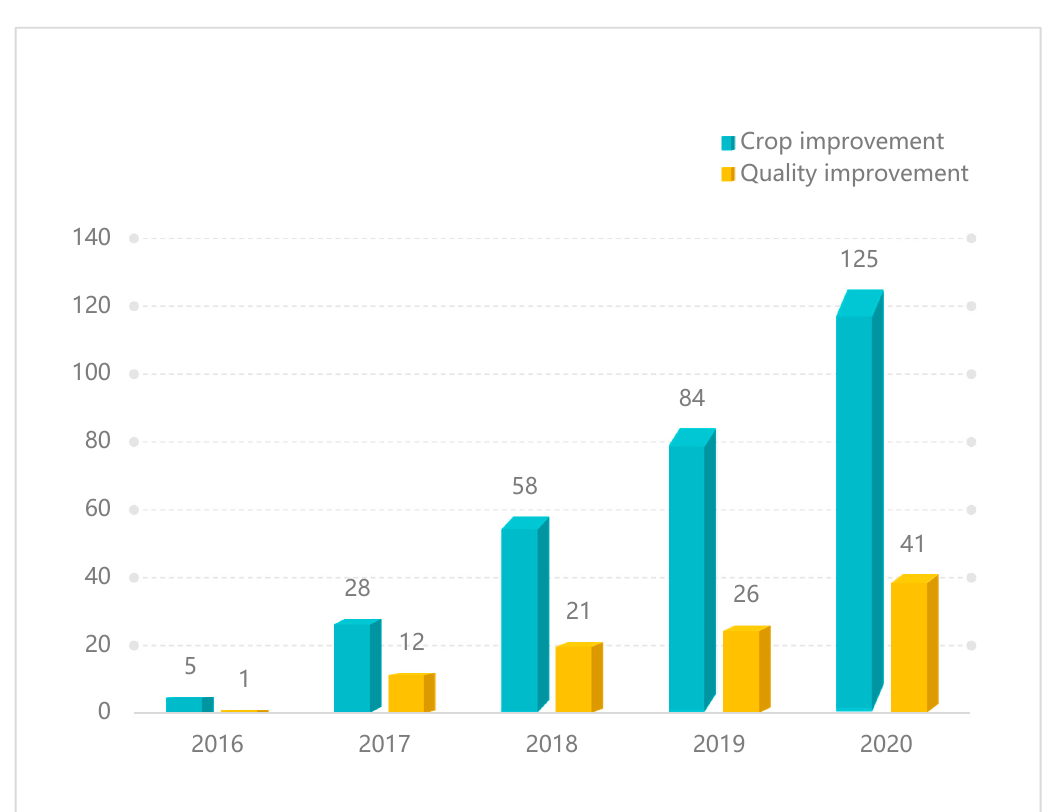
Figure 2. Data on research articles published on CRISPR/Cas9 from 2016 to 2020. ‘CRISPR/Cas9 and crop name’ were used as keywords in the Web of Science search tool (https://webofknowledge.com/) (accessed on 1 April 2021). The literatures aiming at crop improvement were selected and out of them, quality improvement researches were summarized specially, which are shown in blue-green and yellow bar, respectively.